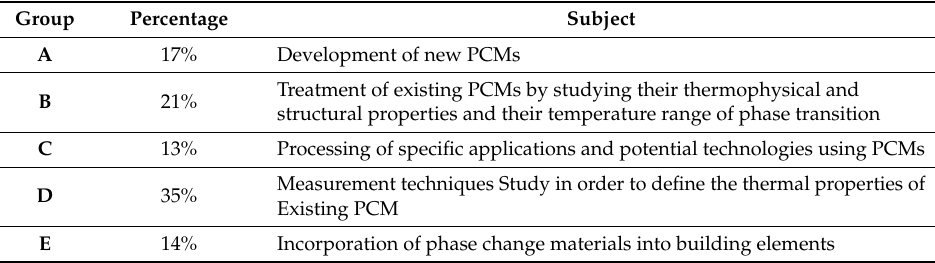
Table 1. Subjects dealing with PCM in the building sector.